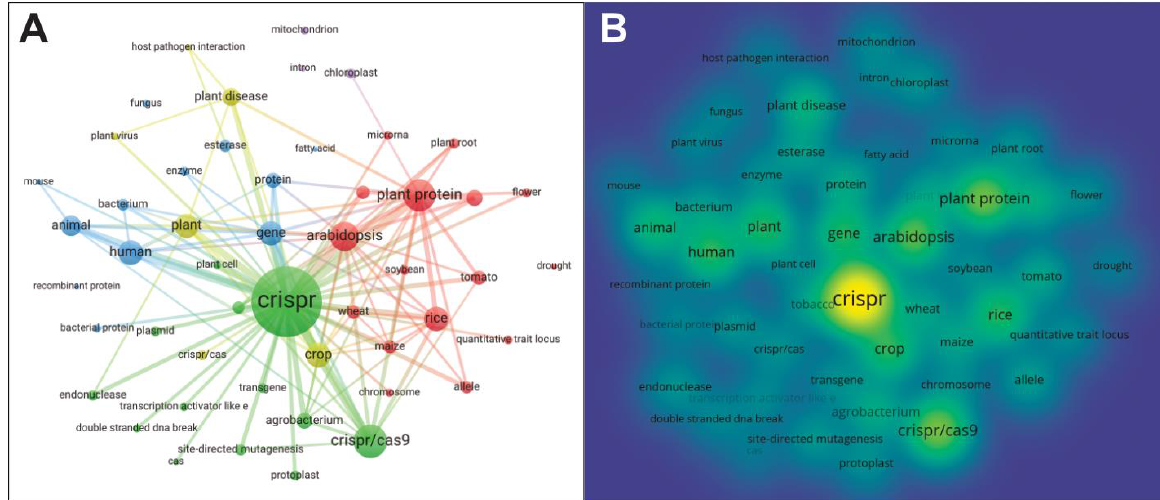
Figure 3. Co-occurrence network of 50 most used keywords in CRISPR-related plant research from 2012 to 2021. ( A ) Network visualization of the keywords based on total link strength. Green, yellow, red, and blue nodes represent four different clusters of keywords identified. A minimum strength of 40 was set for the lines to appear between the nodes. The relatedness of the keywords depends on the number of articles in which they occur together, which is indicated by the size of the nodes/keywords, and the length/thickness of the lines between the nodes. The bigger the nodes/keywords, the larger the weight of the nodes/keywords. The shorter and thicker the lines between the nodes, the more frequently they appear together in the publications. ( B ) Density visualization of the keywords based on occurrences. The density of a keyword depends on the number of keywords around the node. Keywords in the yellow areas indicate a more frequent occurrence in the publications while green areas indicate a less frequent